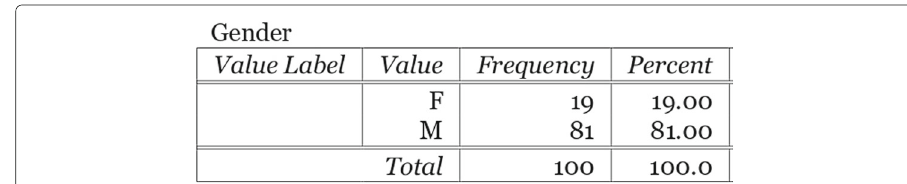
Fig. 12 Gender distribution in the total sampled students